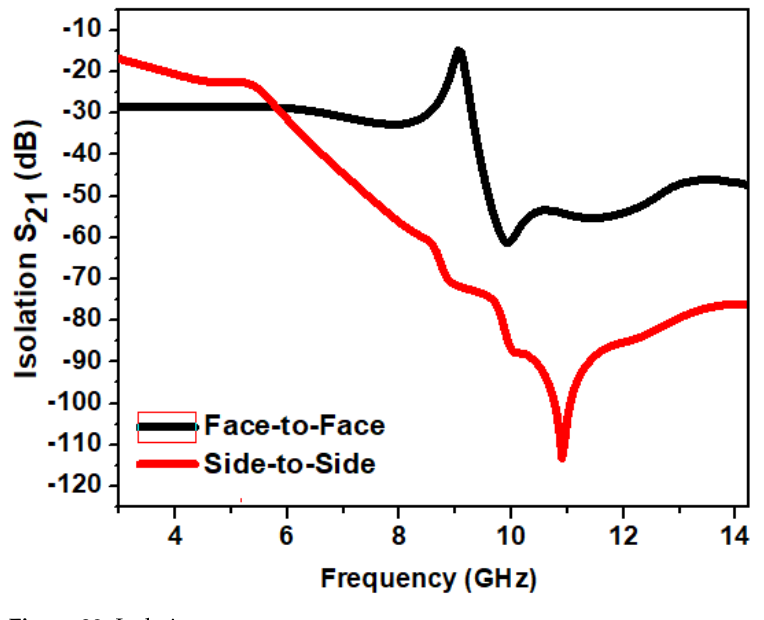
Figure 38. Group delay of notch antenna.